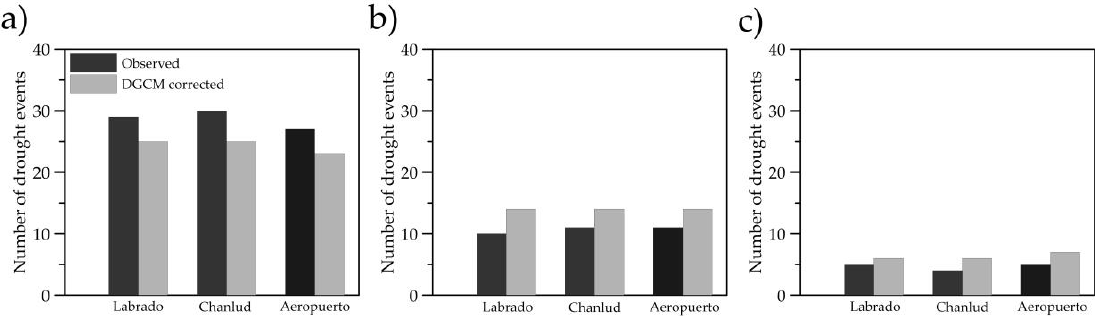
Figure 5. Frequencies of drought categories: ( a ) moderate drought, ( b ) severe drought, and ( c ) extreme drought.